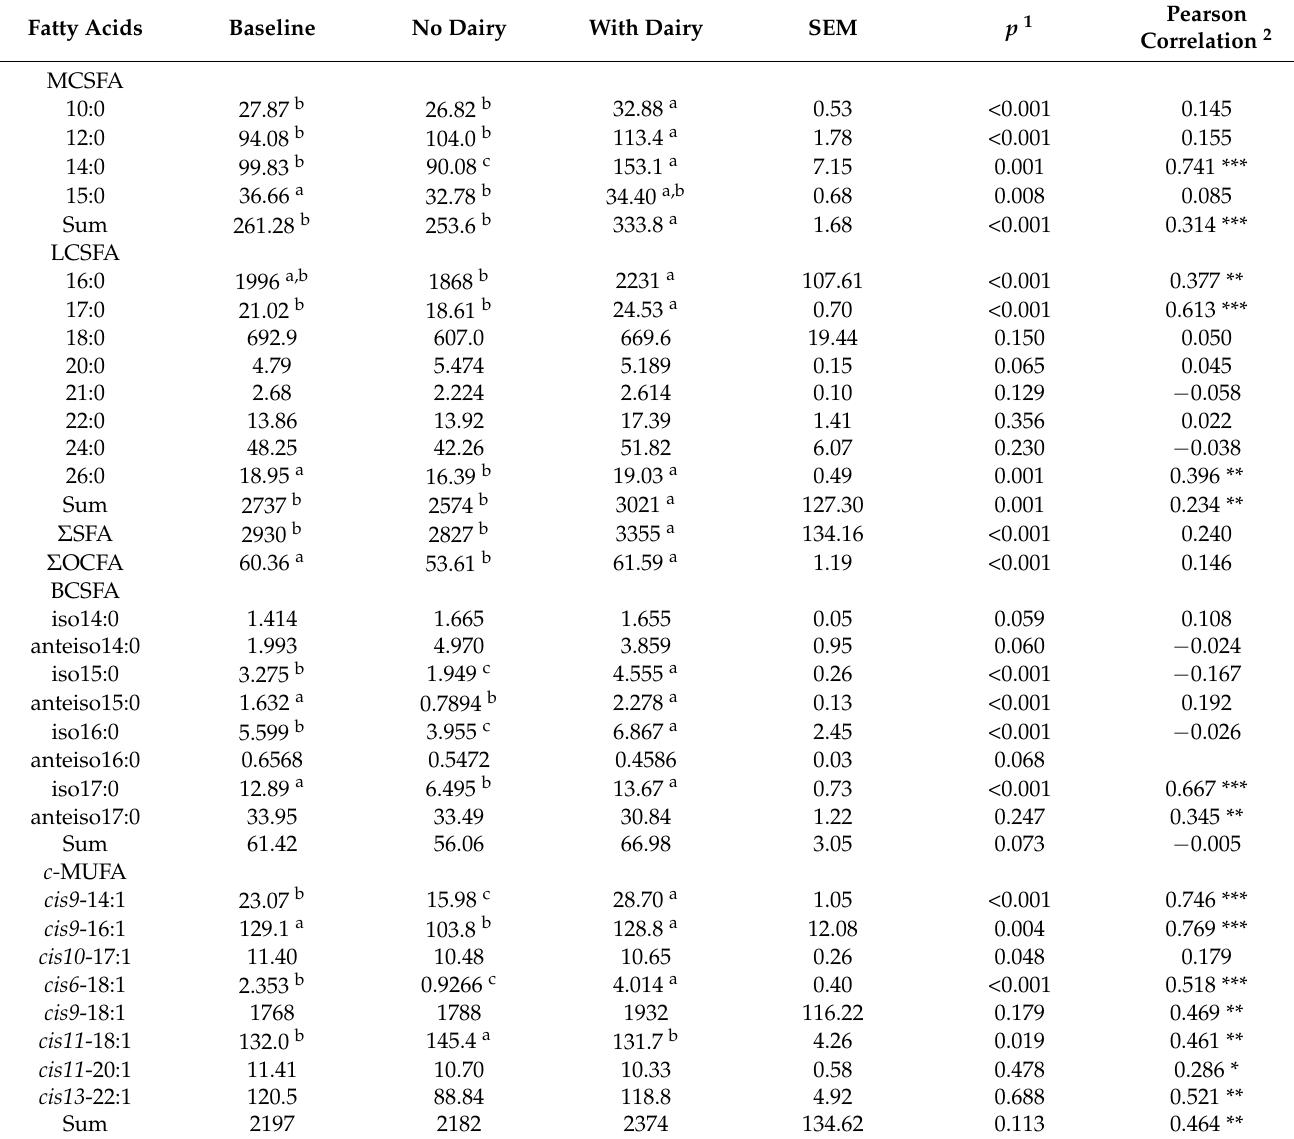
Pearson Correlation 2